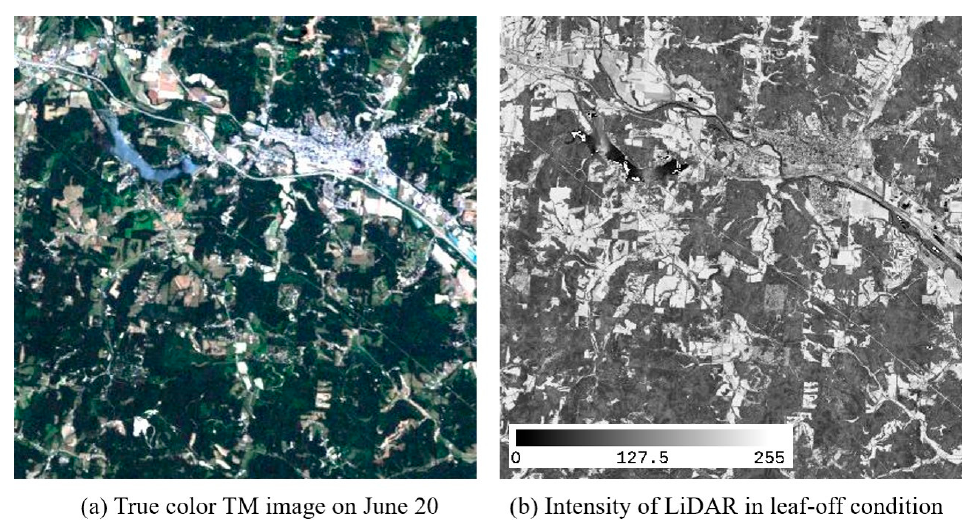
Figure 7. A subset of true color of leaf-on Landsat image on June 20 ( a ) and its corresponding leaf-off LiDAR intensity; ( b ): lower LiDAR intensity is related to Landsat pixels with high forest density (dark green color).